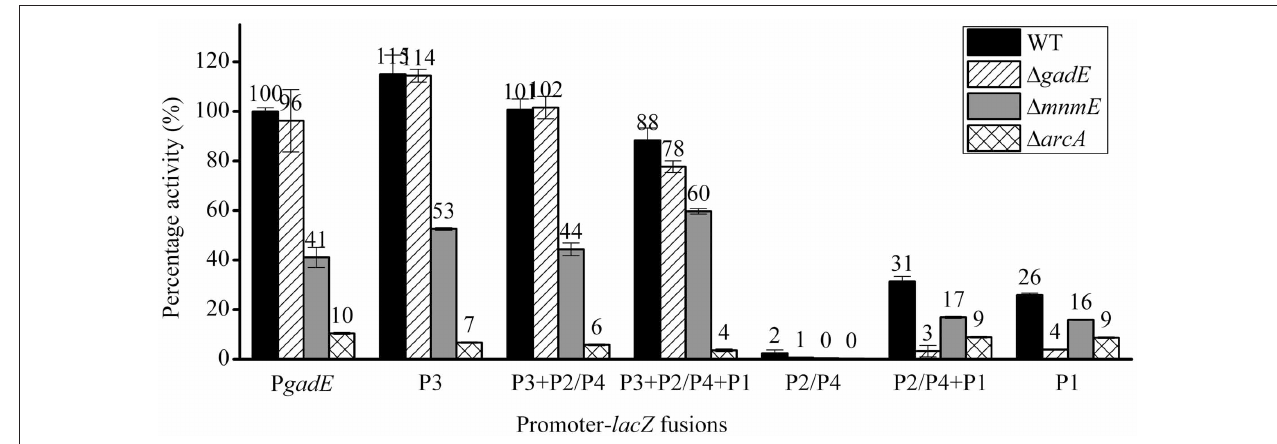
FIGURE 4 | β -galactosidase activity of P gadE truncations in WT (black bars), (cid:2) gadE (stripe bars), (cid:2) mnmE (gray bars) and (cid:2) arcA (grid bars) strains under anaerobic growth condition.